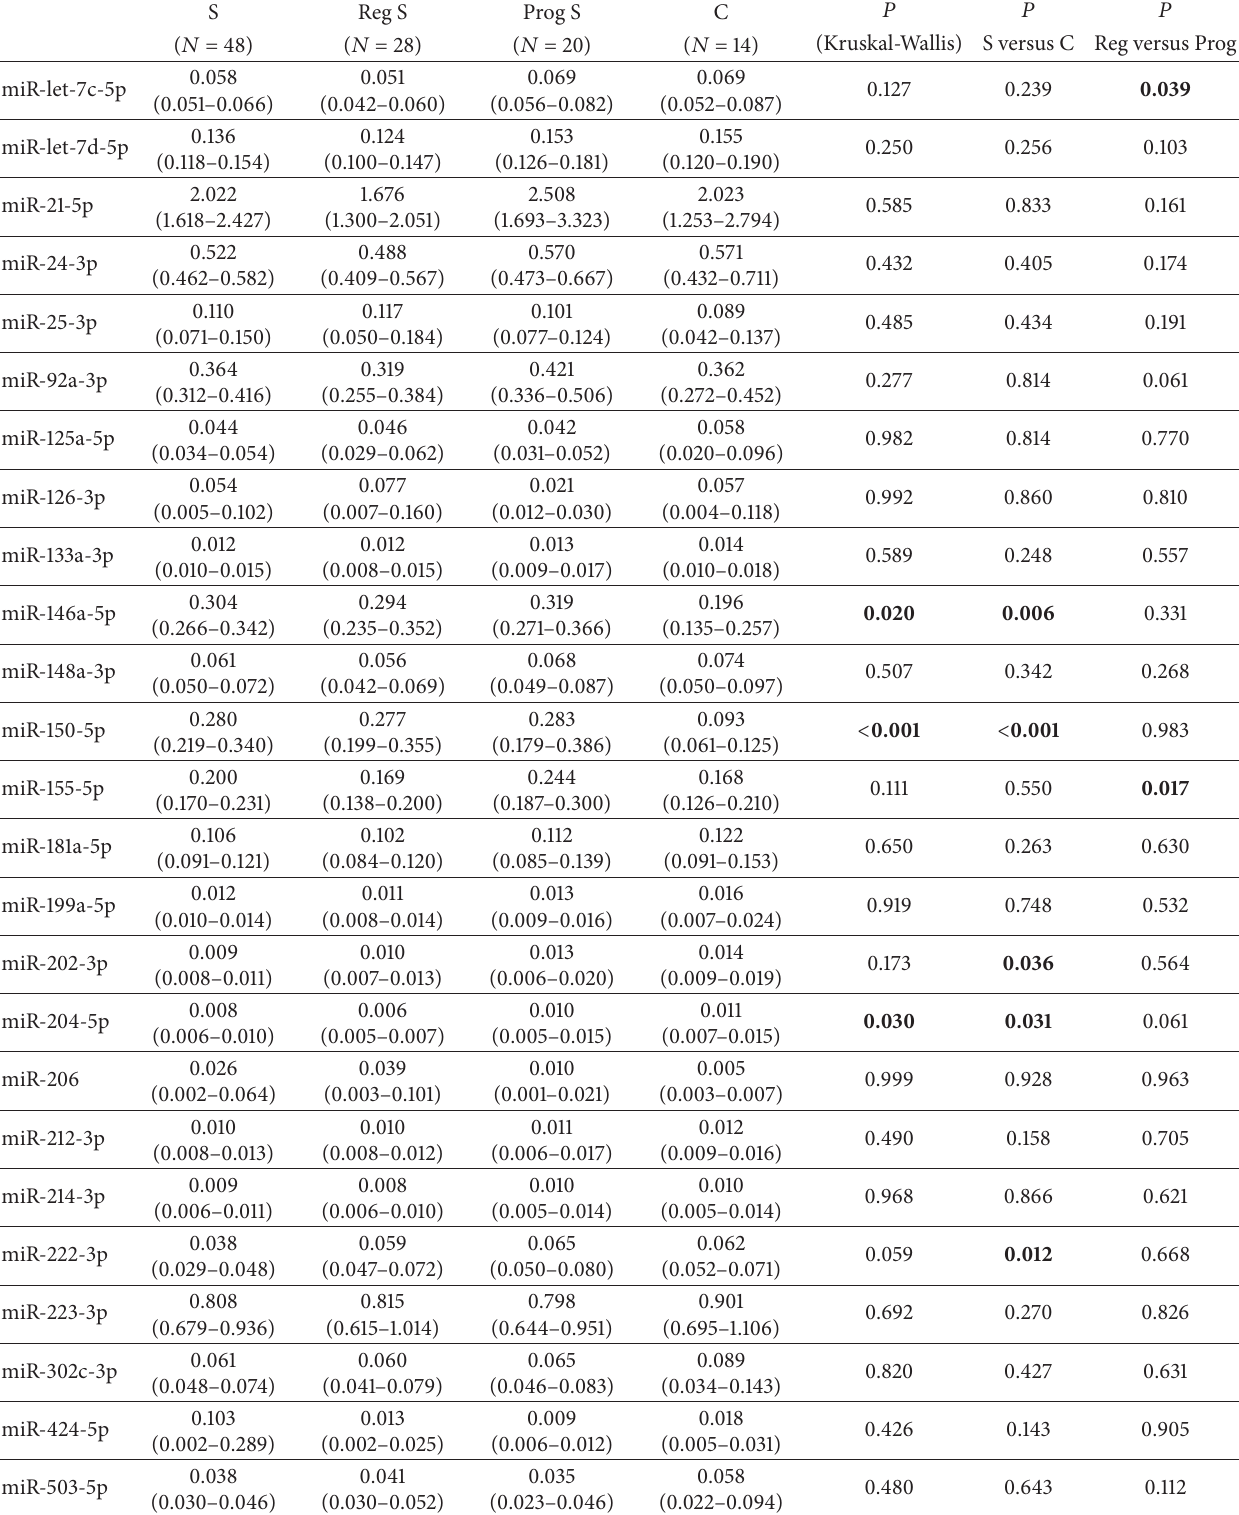
Table 2: Comparison of miRNA expression profiles between sarcoidosis (S) patients, subdivided according to the outcome after 2-year follow-up (Reg: regression; Prog: progression), and control subjects (C). All the data are presented as Mean Expression Level (95% confidence interval). Results are expressed relative to levels of endogenous U6 miRNA. 𝑁 : number of patients. Bold font indicates significant 𝑃